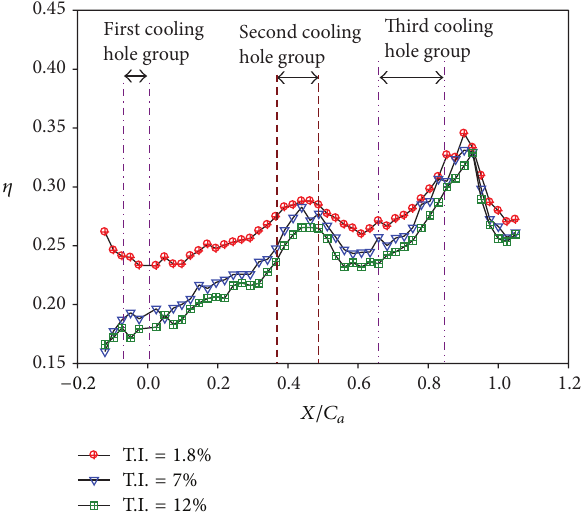
Figure 19: Effect of turbulence intensity on averaged effectiveness for nonstepped endwall (Re = 124000 , 𝑀 = 2 , and 𝑆/𝐶 = 0